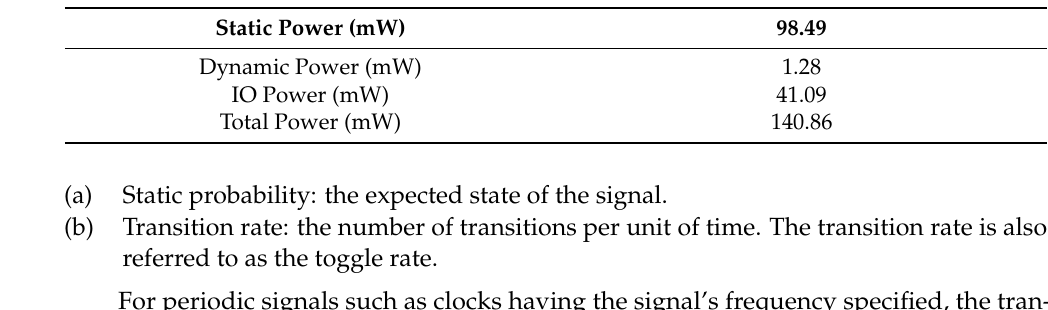
Table 8. Hardware resources of the proposed TRNG.